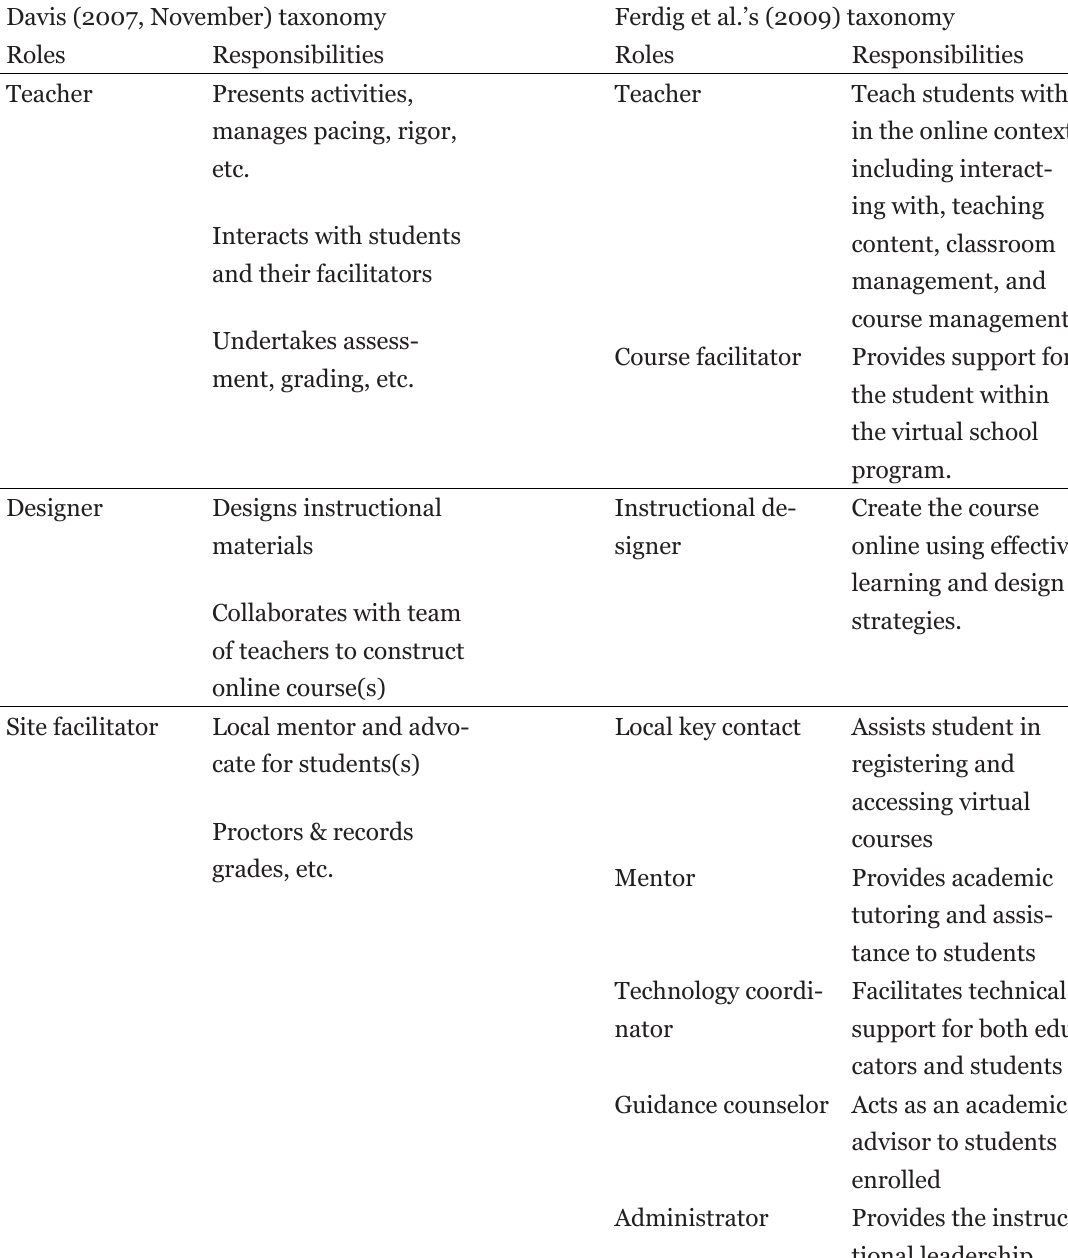
Table 1 Taxonomies of Teacher Roles and Responsibilities in Virtual School Environments Davis (2007, November)